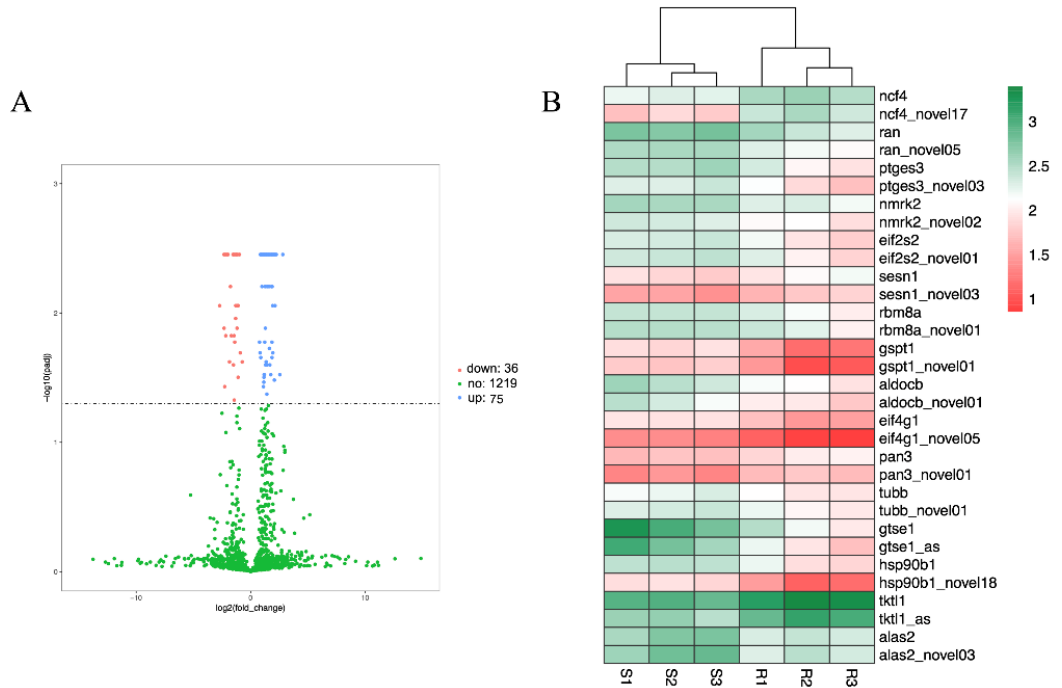
Figure 10. The differentially expressed isoforms between CSBV Bces-Po19-sensitive and -resistant Japanese flounder ( Paralichthys olivaceus ). ( A ) Volcano map of differentially expressed isoforms. Each dot represents one isoform, blue dots represent the significantly up-regulated isoforms, and red dots represent the significantly down-regulated isoforms. Green dots represent isoforms that are not significantly differentially expressed. ( B ) Heatmap analysis of the hierarchical clustering of differentially expressed isoforms with their genes. Different colors indicate differences in the expression